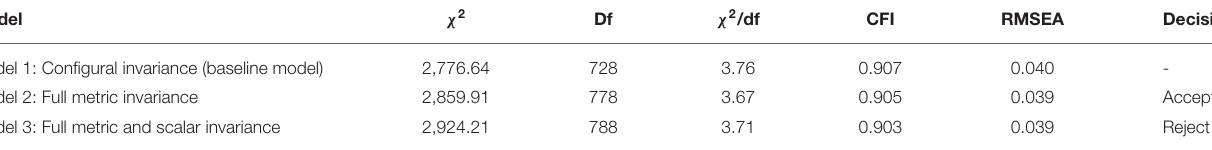
TABLE A2 | Goodness-of-fit statistics across groups: a